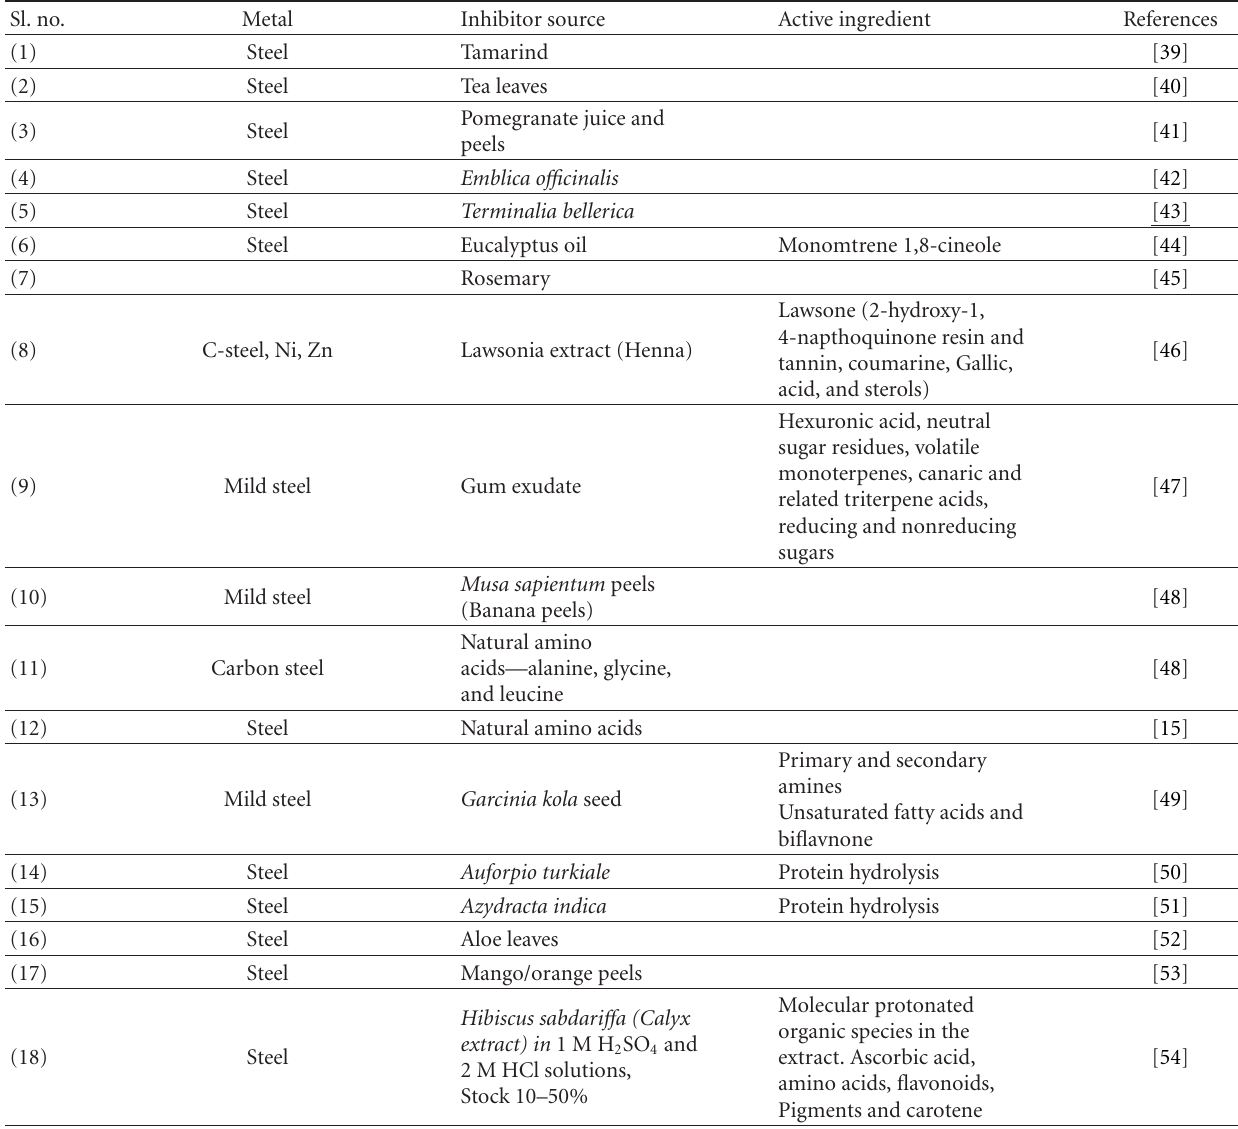
Table 1: Green inhibitors used for corrosion inhibition of